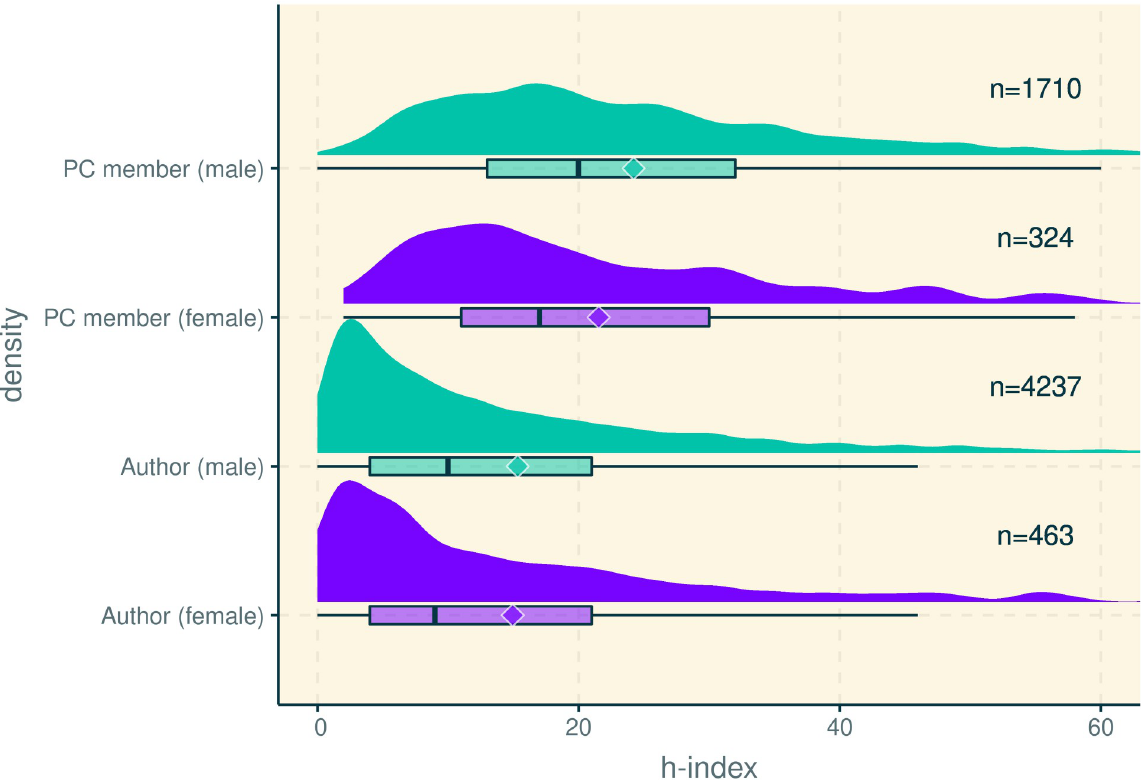
Fig 1. Distribution of h-index by role and gender (diamonds represent means). h-index values extracted from Google Scholar, ca. 2017. Each researcher was counted exactly once, unless no gender or h-index could be identified.